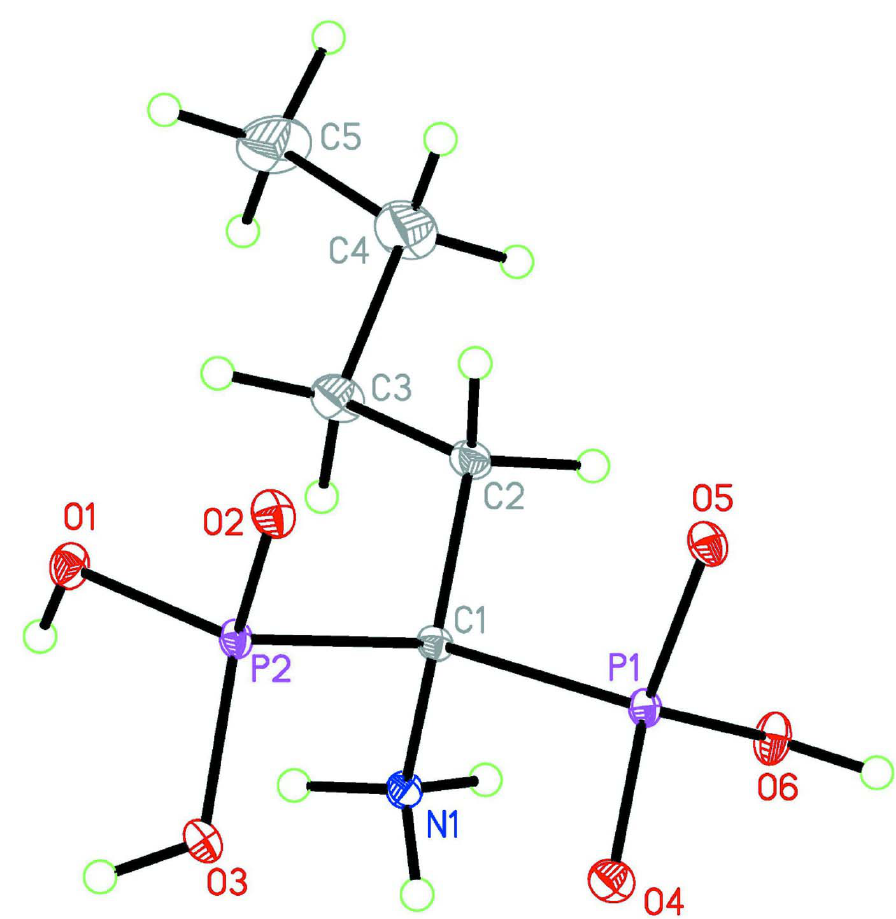
The asymmetric unit of the title compound showing the atom-labelling scheme and 50% probability displacement ellipsoids for the non-hydrogen